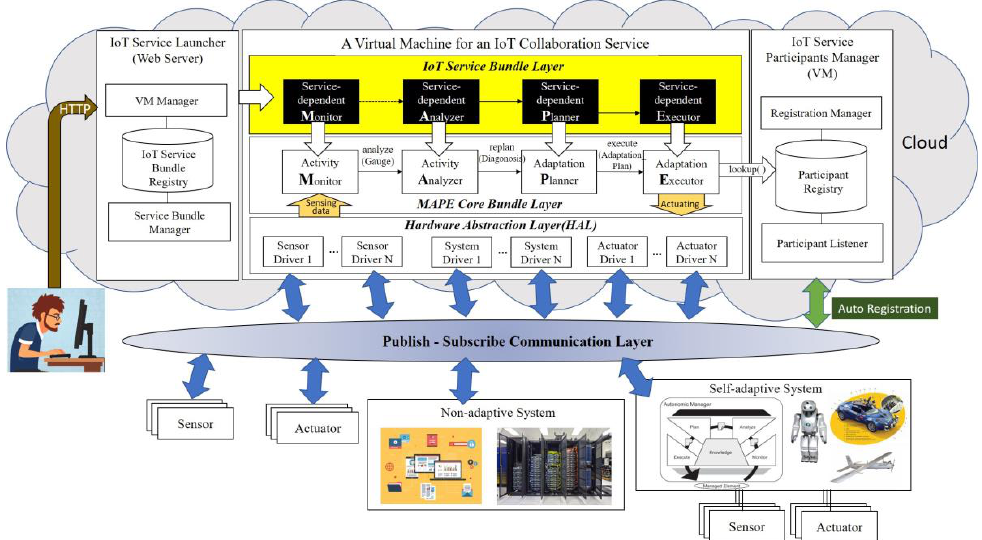
Figure 1. Conceptual architecture overview for cloud-based self-adaptive middleware platform for IoT collaboration services.